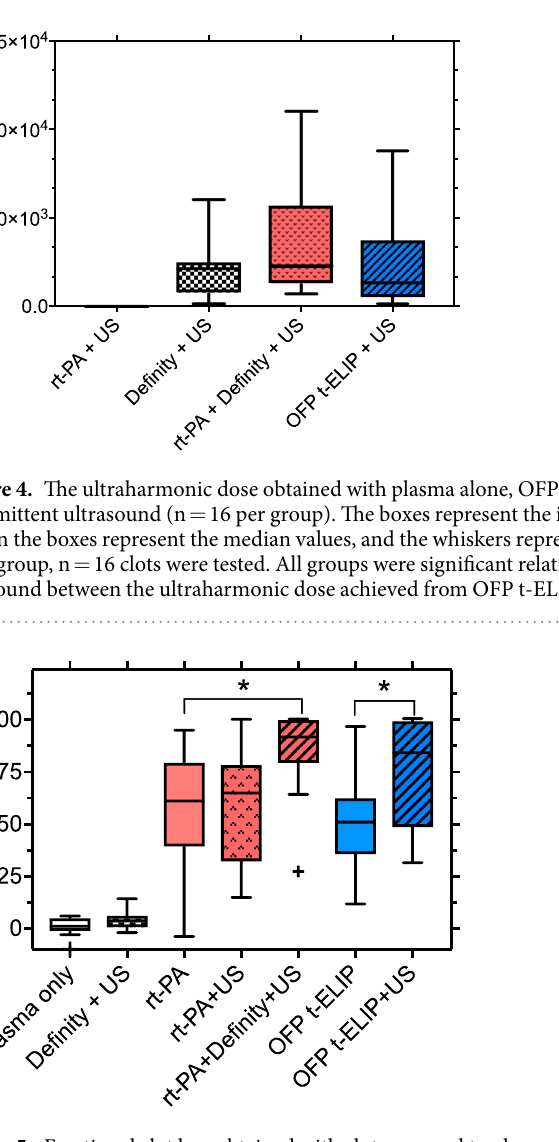
Figure 5. Fractional clot loss obtained with clots exposed to plasma alone, rt-PA, rt-PA + US, rt-PA + Definity + US, and rt-PA + Definity + US. For each group, n = 16 clots were tested. The error bars represent ± 1 standard deviation. The ‘ + ’ sign denotes an outlier. Differences ( p < 0.05) across treatments are denoted by ( *